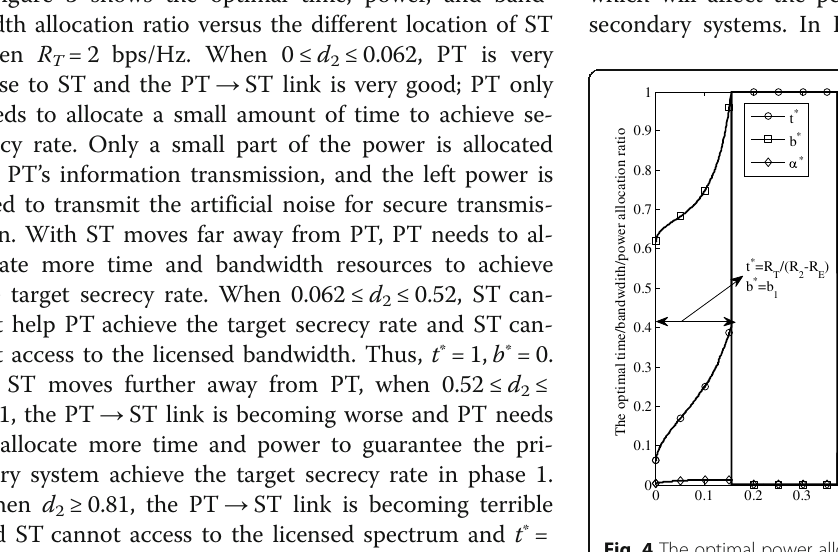
Fig. 4 The optimal power allocation ratio versus d